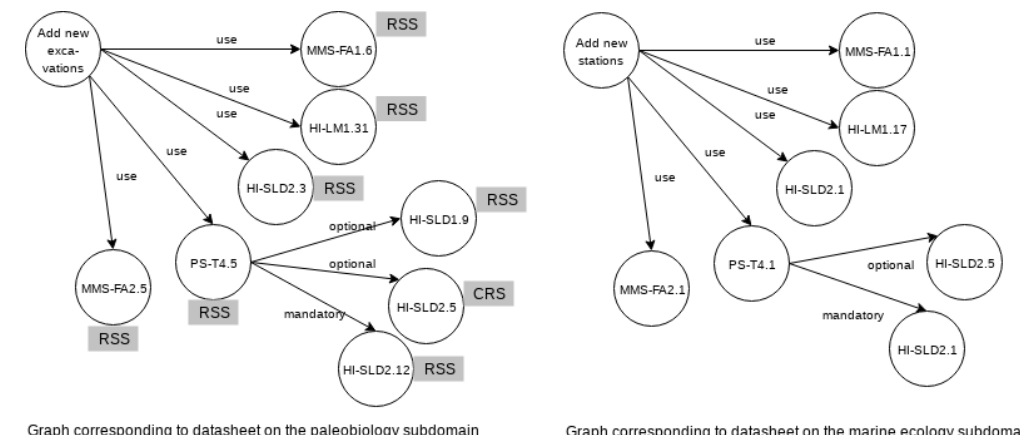
Figure 15. Graphs generated from the datasheets of the two